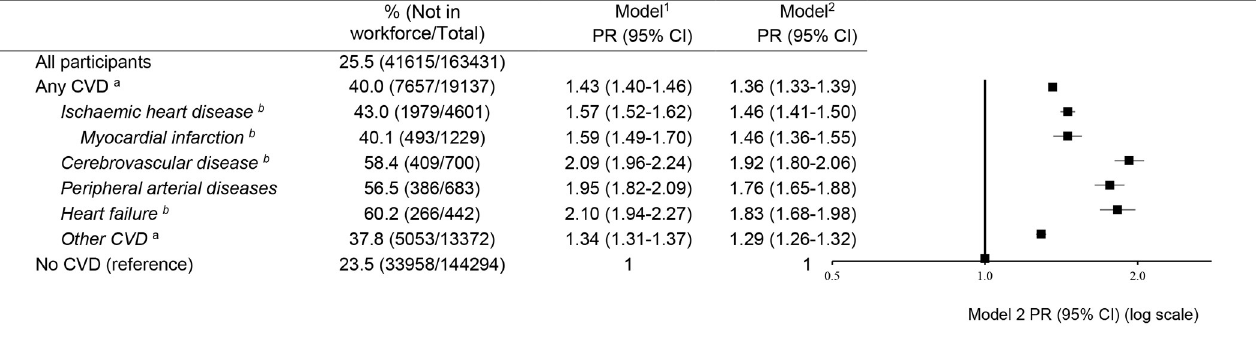
Fig 2. Non-participation in the workforce: Prevalence and adjusted prevalence ratios in people with and without CVD and according to hospitalisation for CVD subtypes.